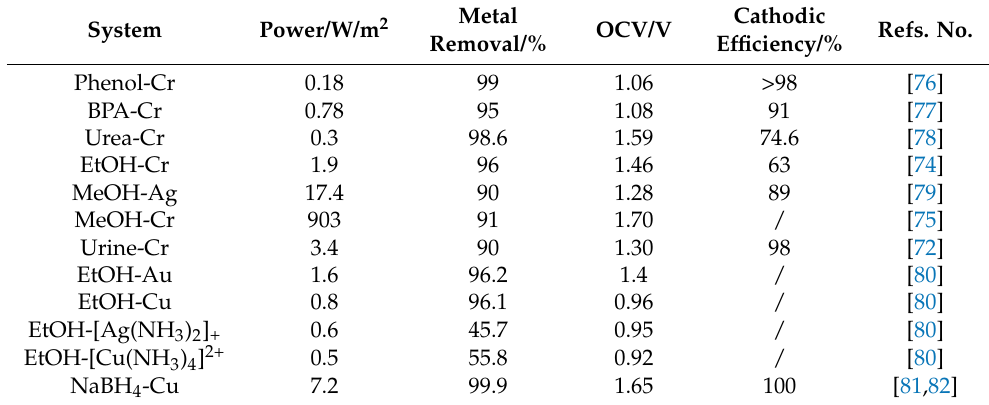
Figure 6. Typical pollutants’ redox potentials and their possible combination in coupled redox fuel cells. In CRFCs, due to its high oxidation potential and toxic properties in the environment, Cr(VI) was mostly studied. In addition, other metals with higher oxidation potential such as Au(III), Ag(I), Cu(II) and their chelated ions also showed promising recovery and electricity generation performance. Though the publications in this field are relatively in shortage, in order to compare the performance of different CRFCs, Table 2 was designed and the corresponding data were shown. From Table 2, it can be roughly seen that the metal removal efficiency and cathodic efficiency are usually high for different metals, though these data may vary by using different reaction times. In addition, the open-circuit voltage and the power output can be greatly varied by changing the reaction temperature, pH and metal ions because these reactions are thermodynamically affected by these parameters. Table 2. Performance comparison of different